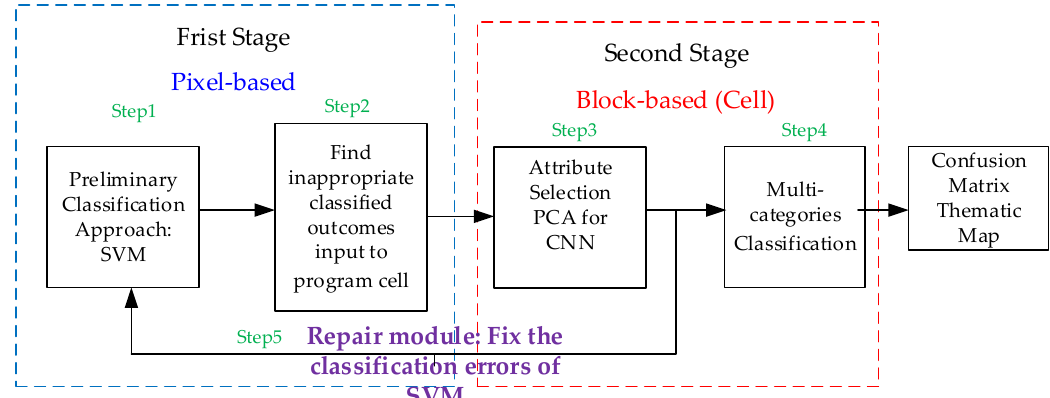
Figure 3. Research steps of the study.